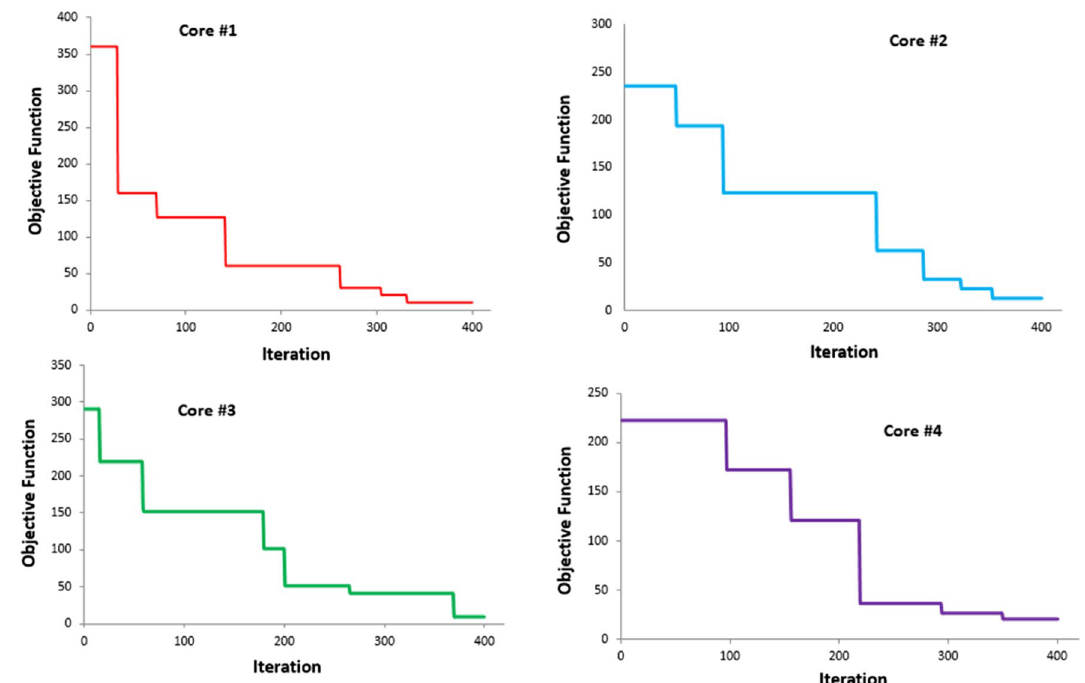
Fig. 10 Variation of objective function versus iteration number for gas–oil